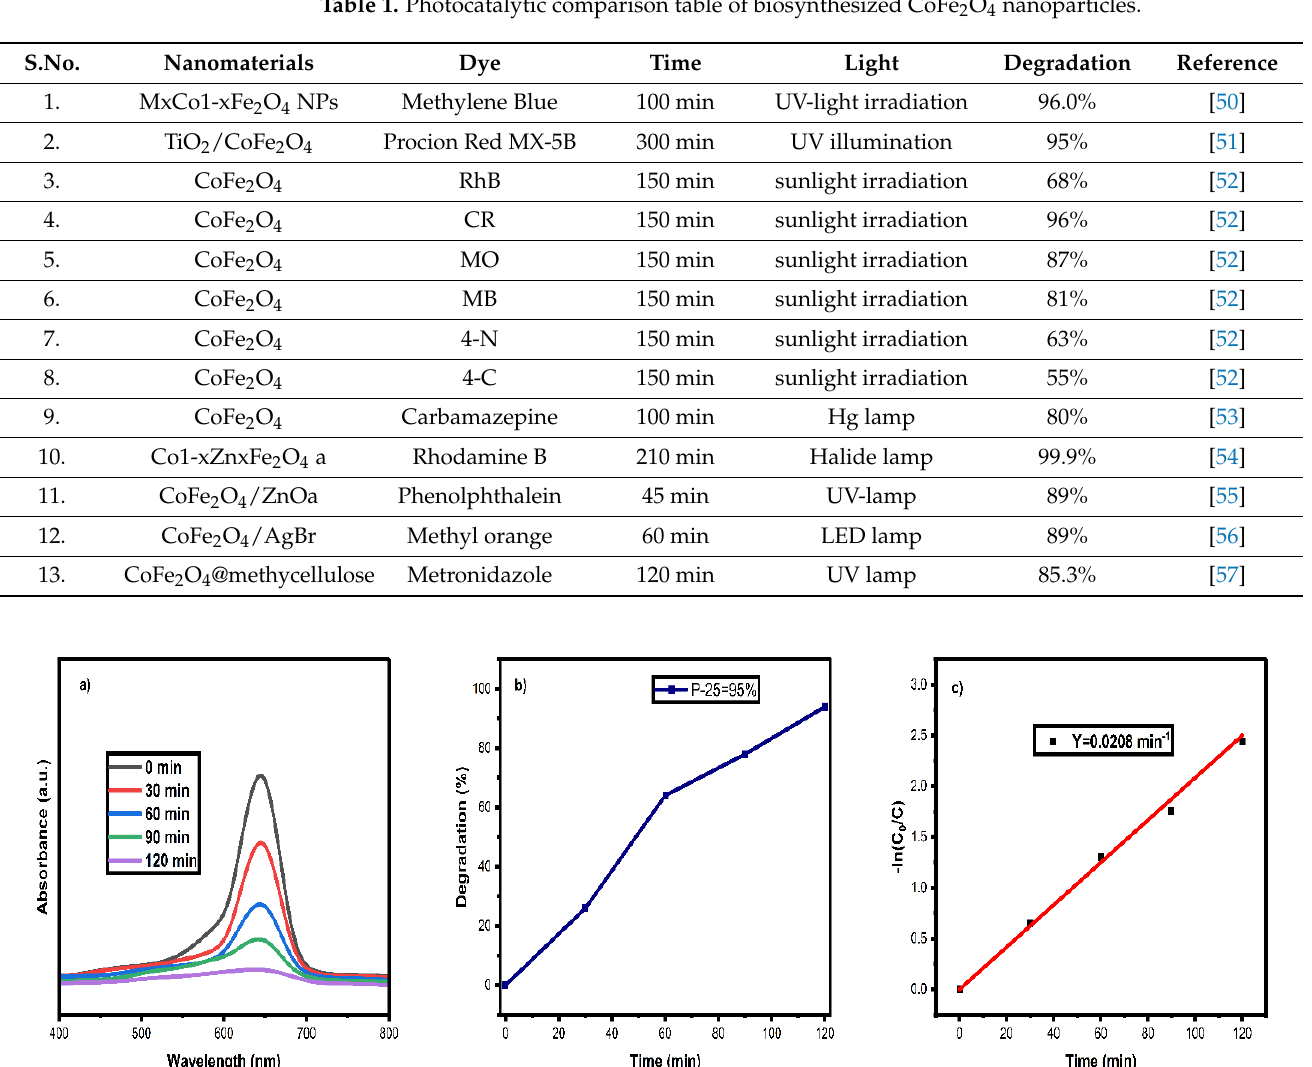
Table 1. Photocatalytic comparison table of biosynthesized CoFe 2 O 4 nanoparticles.